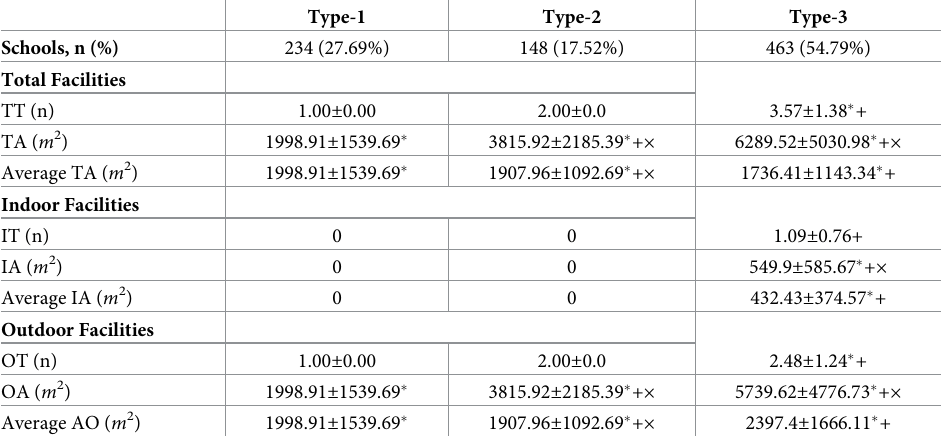
Table 3. Descriptive statistics of classified PSSFC by using machine learning (n =